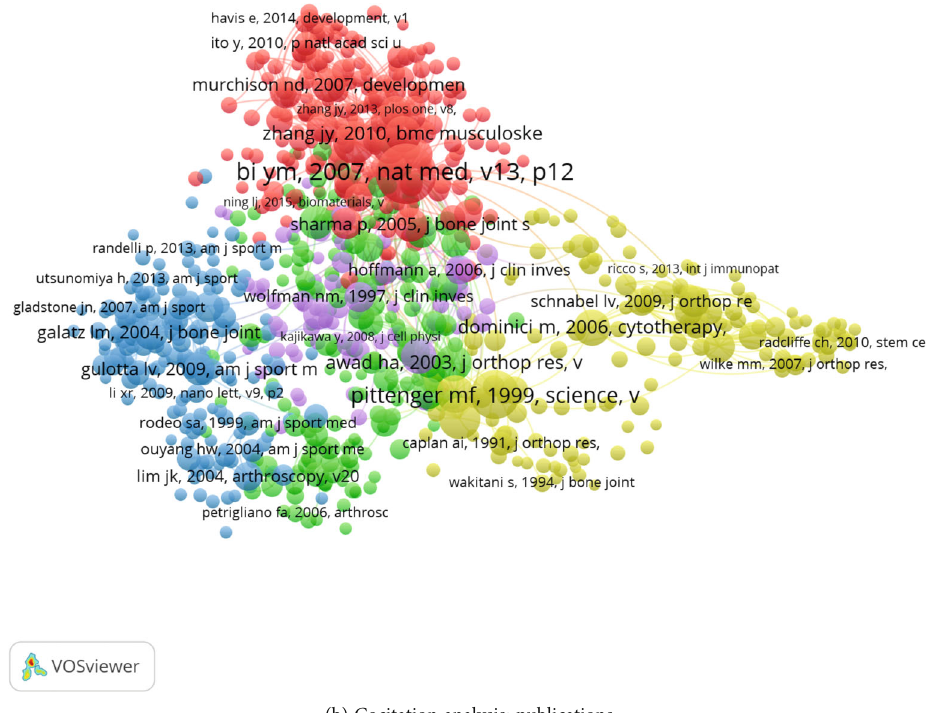
Figure 5: Cocitation analysis of global research of tendon stem cells. (a) Mapping on the 825 identi fi ed journals by cocitation analysis. (b) Mapping on the 808 identi fi ed references by cocitation